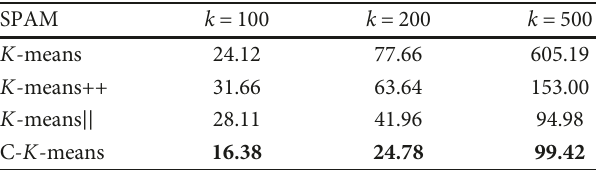
Table 11: Times (in minutes) for SPAM.